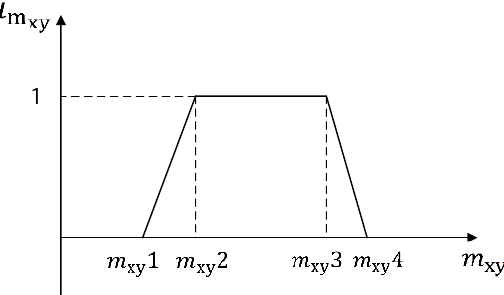
Table B1. Unit parameters. Unit Type